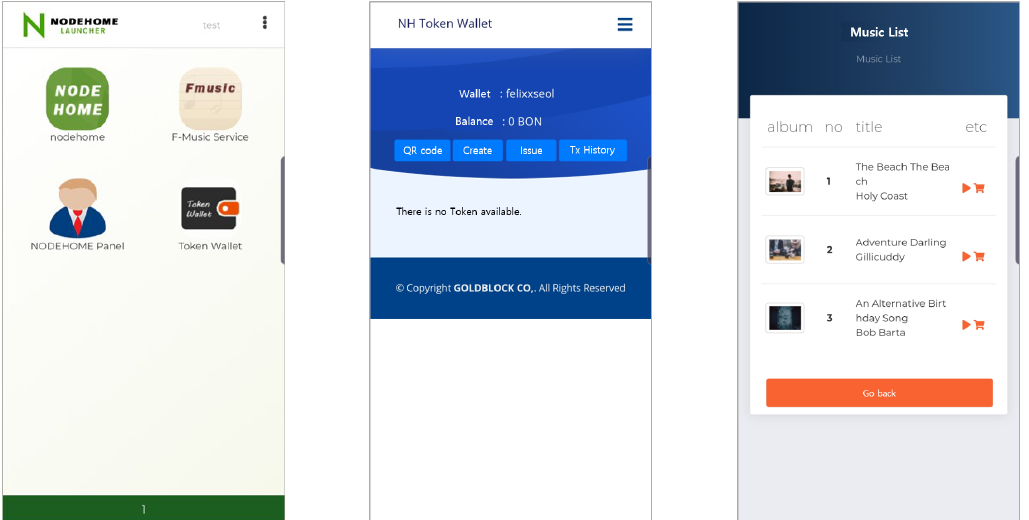
Figure 9. Screenshots of Nodehome mobile applications. From the left are the launcher main, wallet, and fMusic -music streaming